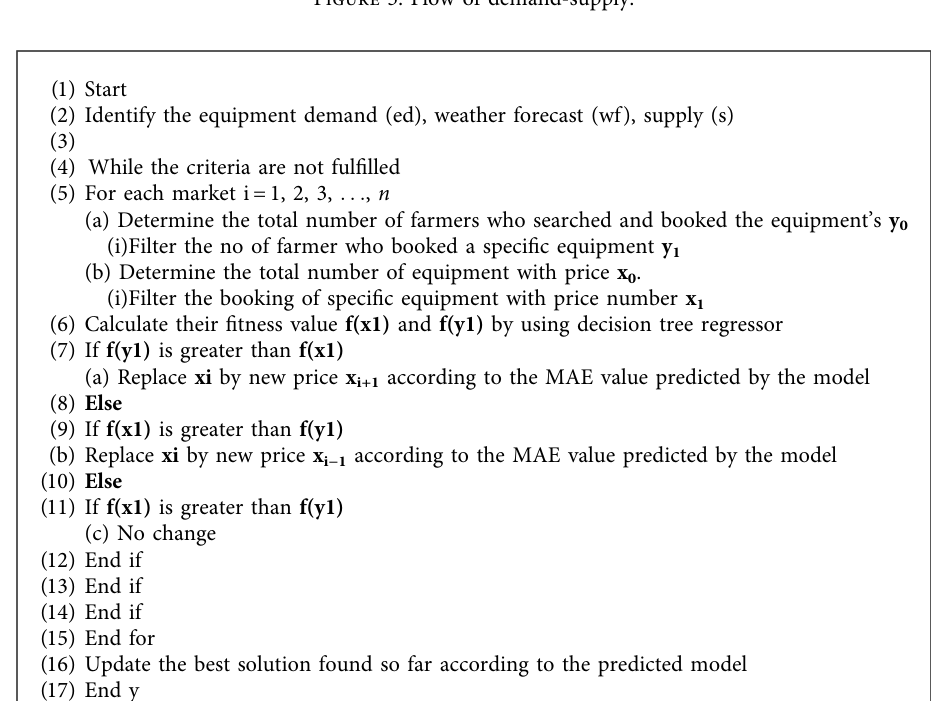
Figure 5: Flow of